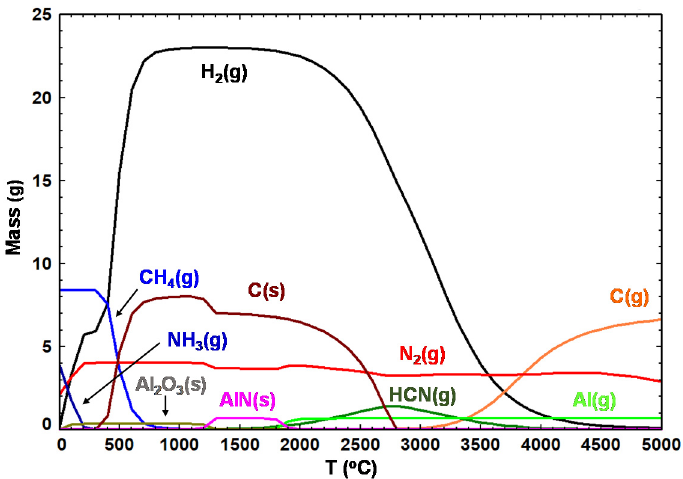
Figure 3. Modelling by FactSage™ showing the limited potential of producing AlN from urea through plasma. through plasma.